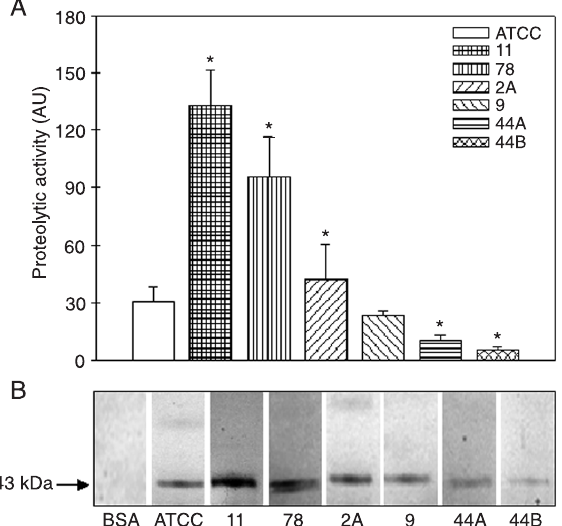
Figure 3. A , Measurement of secreted aspartyl peptidase activ- ity on BSA in clinical isolates of Candida albicans . After growth in YCB-BSA medium for 48 h at 37°C under slight agitation, the cultures were harvested and filtered and the spent culture media were then tested to degrade soluble BSA. Each cell-free culture supernatant was supplemented with BSA and 10 mM so- dium citrate, pH 4.0, and subsequently incubated at 37°C for 2 h. The proteolytic activity was determined as described in Material and Methods and is reported as arbitrary units (AU). The values are reported as the means ± SEM of three independent experi- ments, which were performed in triplicate. Asterisks denote trail- ing clinical isolates that showed a rate of substrate hydrolysis significantly different from the ATCC strain (*P < 0.05, Student t -test). B , Western blotting analysis showing the detection of Sap protein in each C. albicans isolate. The proteins in the spent cul- ture media were separated by SDS-PAGE and transferred to a nitrocellulose membrane. A control in which the culture medium was collected before the yeast inoculation is shown (lane BSA). The blot was sequentially incubated with rabbit anti-Sap1-3 poly- clonal antibody at 1:1000, peroxidase-conjugated goat anti-rabbit IgG at 1:5000 and then developed with enhanced chemilumines- cence reagents. The molecular mass of the reactive polypeptide, reported as kilodaltons (kDa), is given on the